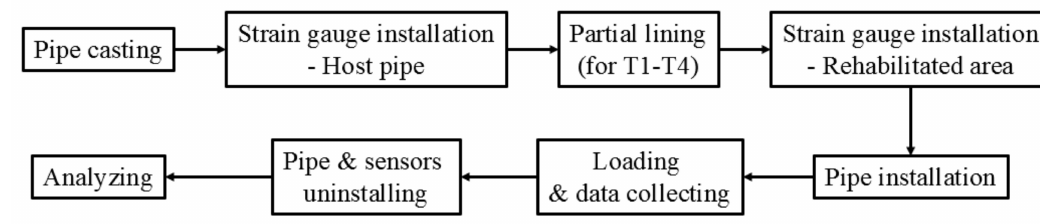
Figure 6. Main procedures of TEBTs.